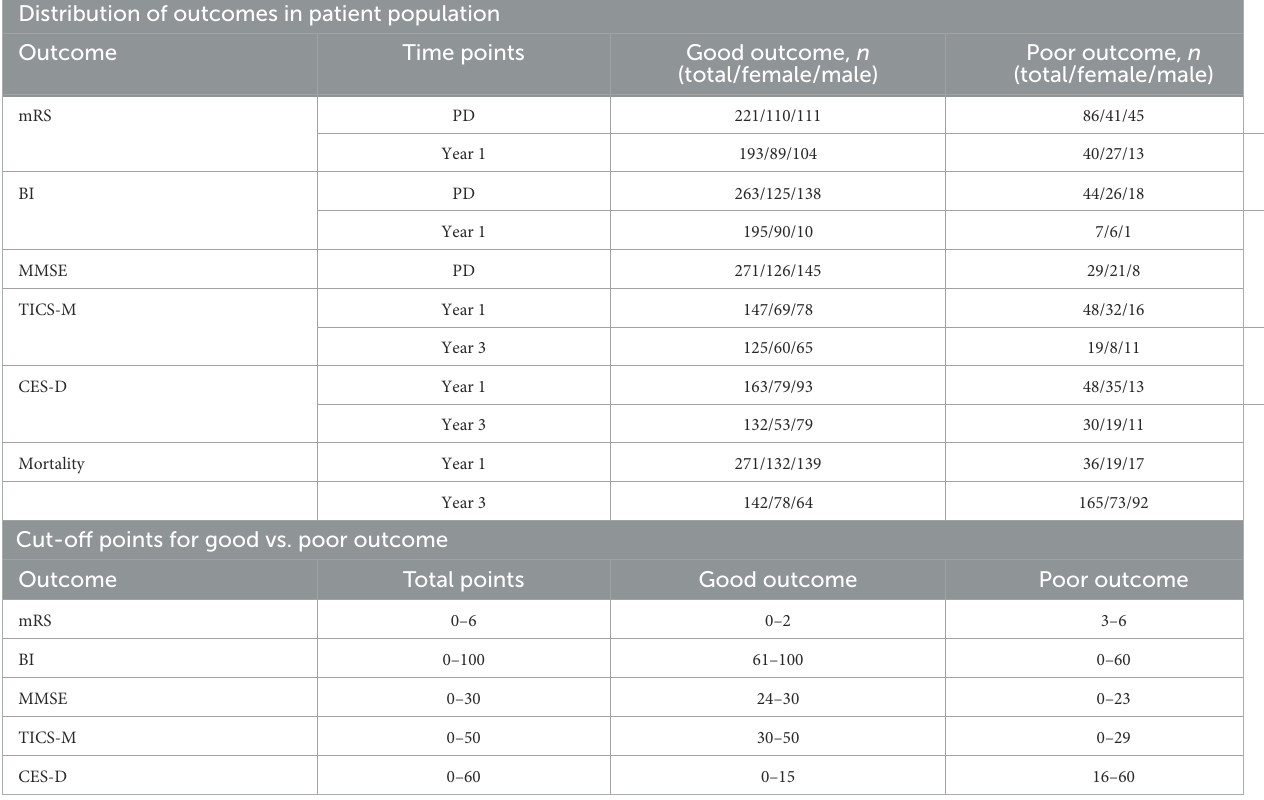
TABLE 2 Cut-offs and distribution of outcomes, listed as frequency for patient numbers in total, males, and females. Distribution of outcomes in patient population